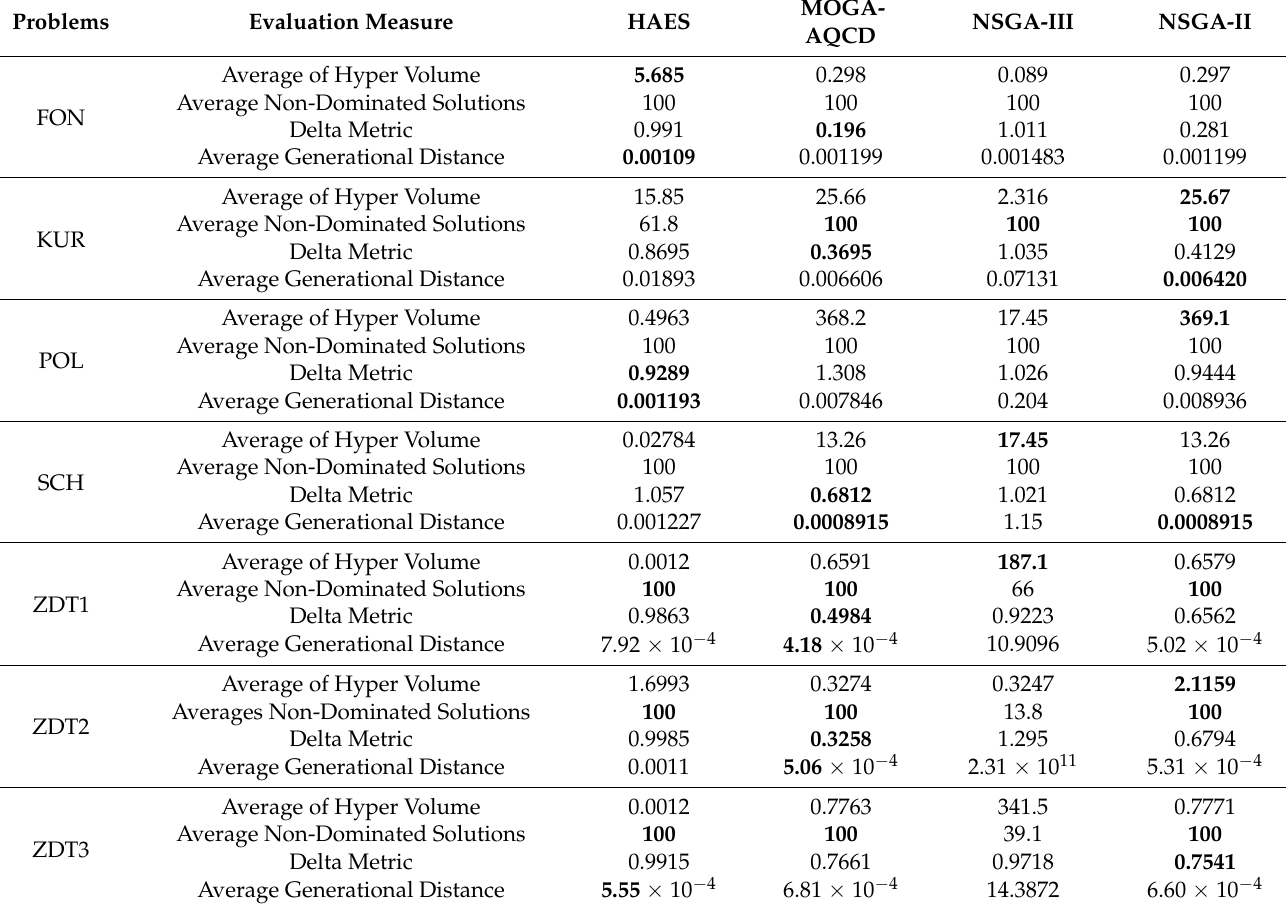
Table 9. Average of MOO metrics for benchmarking mathematical